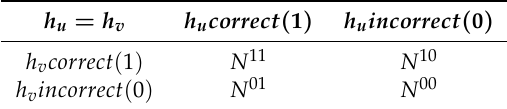
Table 1. The correlation of a pair of classifiers (2 ×